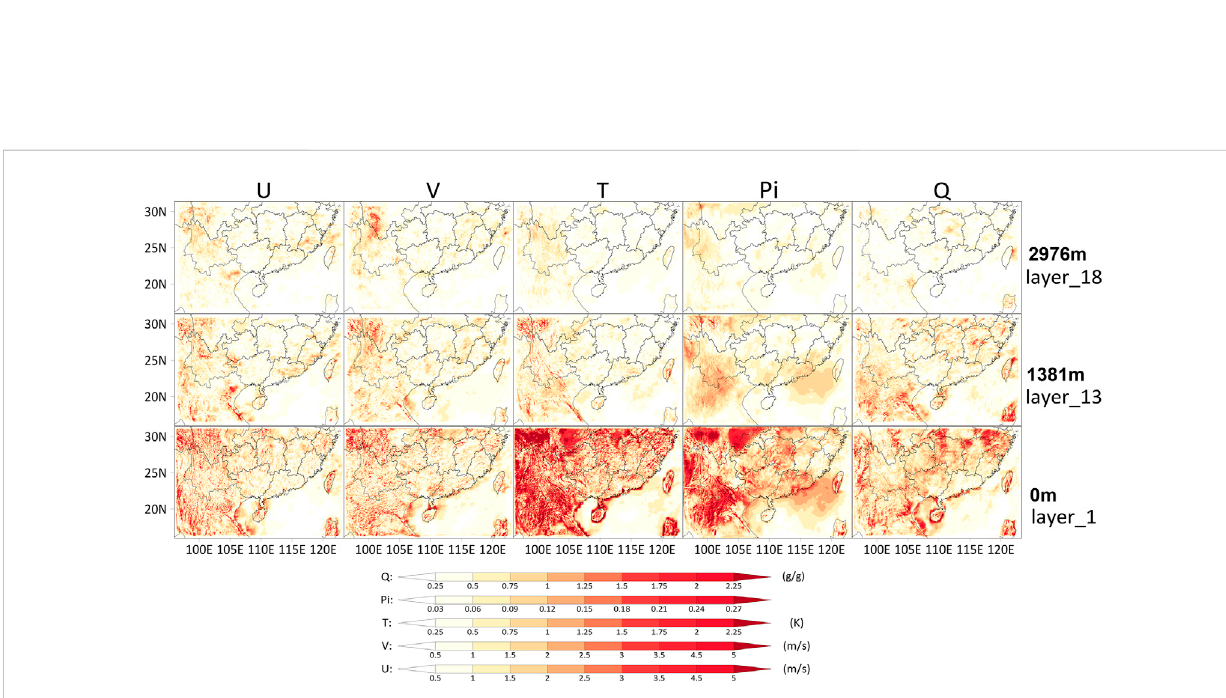
The spatial distribution of the DBA at 1, 13, and 18 model layers (Pi and Q are multiplied by